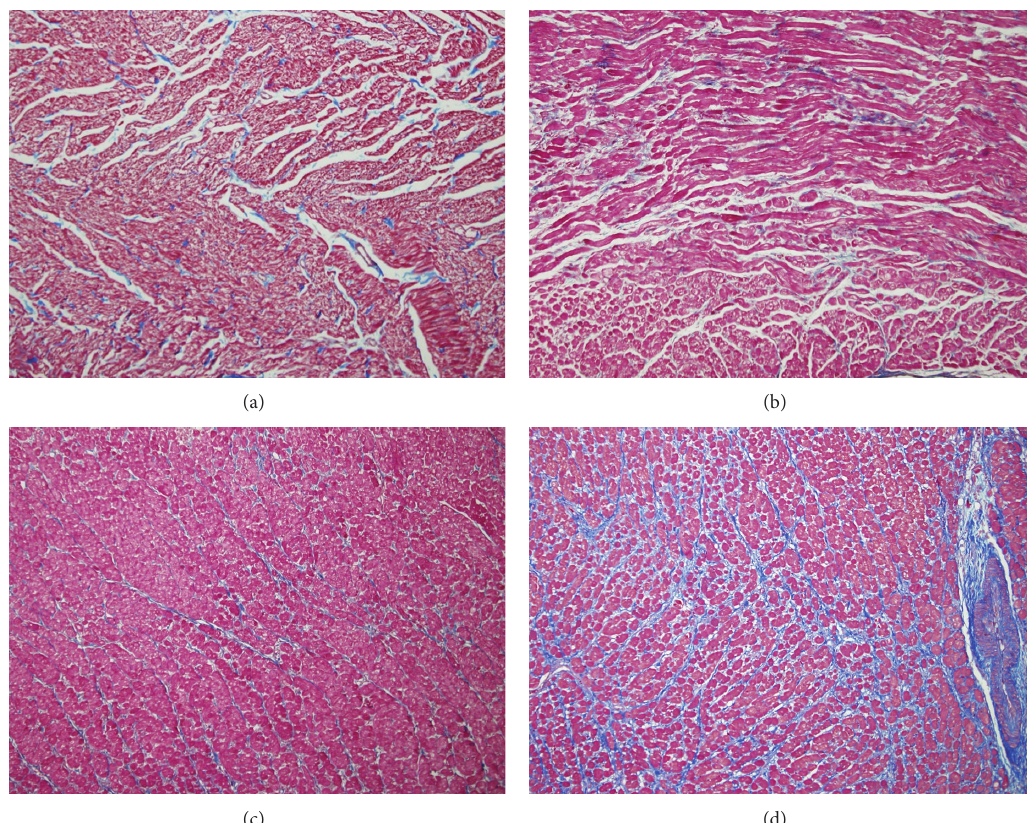
Figure2:Representativehistologicalsectionsofatriaandventriclesfromoldandyoungrabbits.(a)Atrialcrosssectionfromayoungrabbit(3- 4 months). (b) Atrial cross section from an old rabbit (4–6 years). Neither atrial section showed appreciable interstitial fibrosis. (c) Ventricular cross section from a young rabbit. (d) Ventricular cross section from an old rabbit. Note the marked interstitial fibrosis and scar compared to